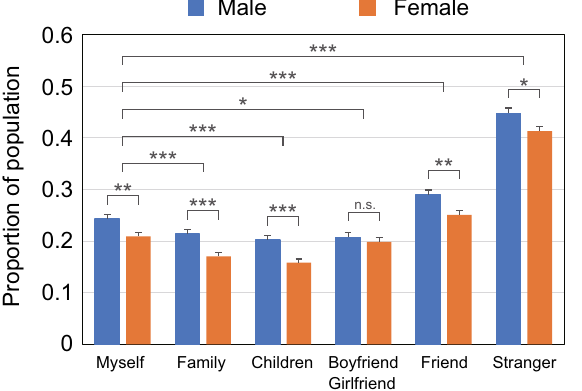
Figure 3. Preference of World-AI for each diagnostic target in the first survey in Japan. Significant gender differences between males (blue) and females (orange) are indicated by asterisks for some diagnostic targets. The respondents’ choice of World-AI diagnosis for themselves and others differed significantly. Note that the respondents chose a World-AI diagnosis for their family, children, and significant others less often than for themselves but chose this diagnosis form more often for their friends and strangers than for themselves. See also Fig. S1 and Tables S3 and S4 for detailed results in other countries/areas. We examined these differences in each response by performing Pearson’s chi-square test with Yates’ continuity correction. Significant codes are shown as follows: ‘*’ as p < 0.05, ‘**’ as p < 0.01, ‘***’ as p < 0.001, and ‘n.s.’ for